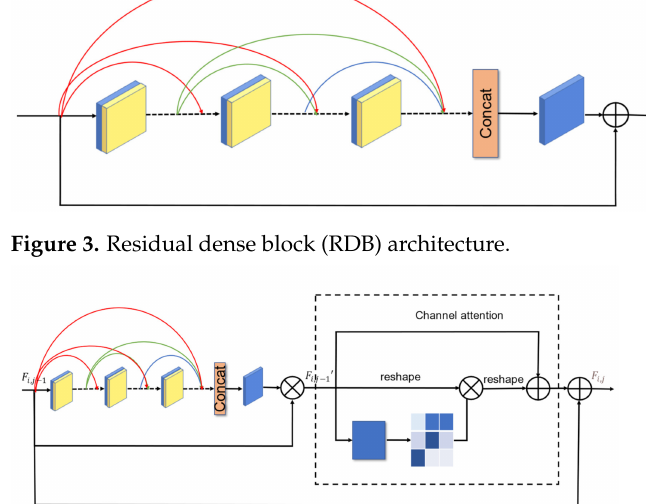
Figure 4. Residual dense channel attention block (RDCAB) architecture.